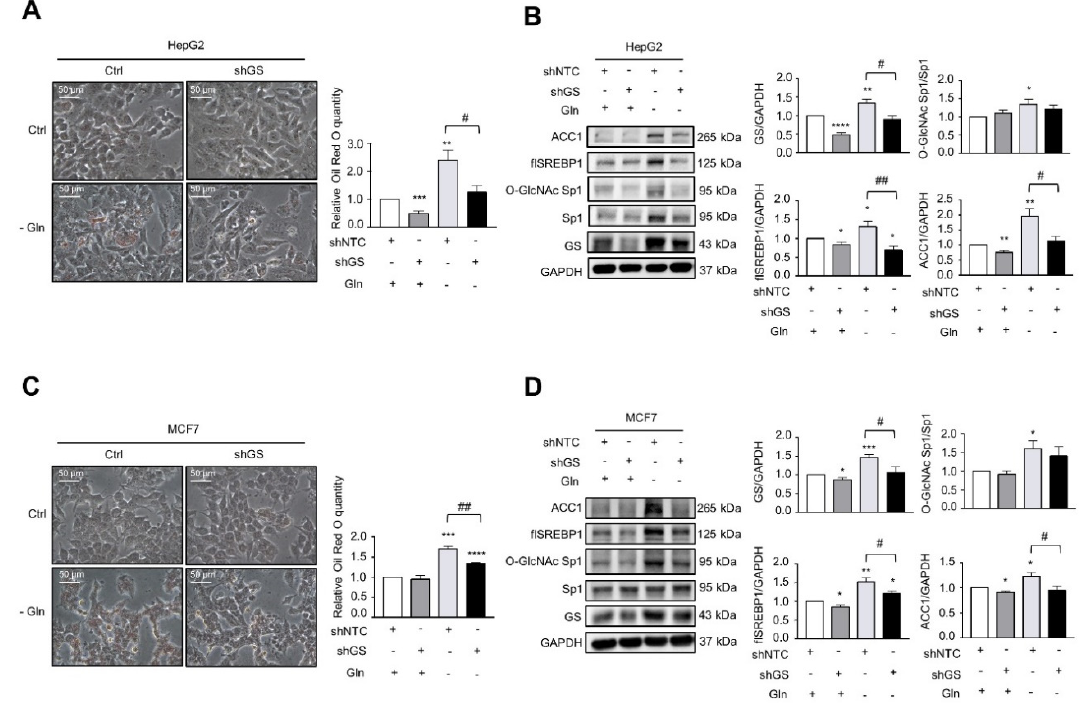
Figure 5. Knockdown of GS attenuates glutamine deprivation-induced LD formation and O-GlcNAc-Sp1/SREBP1/ACC1 expression. ( A , B ) HepG2 cells stably transfected with non-targeting control or GS shRNA were cultured under glutamine deprivation (-Gln) for 24 h. ( C , D ) MCF7 cells stably transfected with non-targeting control or GS shRNA were cultured under glutamine deprivation (-Gln) for 24 h. ( A , C ) LD was stained with Oil Red O and normalized to protein concentrations for the quantitative analysis. ( B , D ) Cell lysates were analyzed by Western blot with specified antibodies. flSREBP1: full-length SREBP1. The bar graphs on the right represent the densitometry analyses of the ratios of indicated proteins. Data represent means plus SEM. * p < 0.05, ** p < 0.01, *** p < 0.001, and **** p < 0.0001 compared to control cells. # p < 0.05 and ## p < 0.01 between indicated groups.